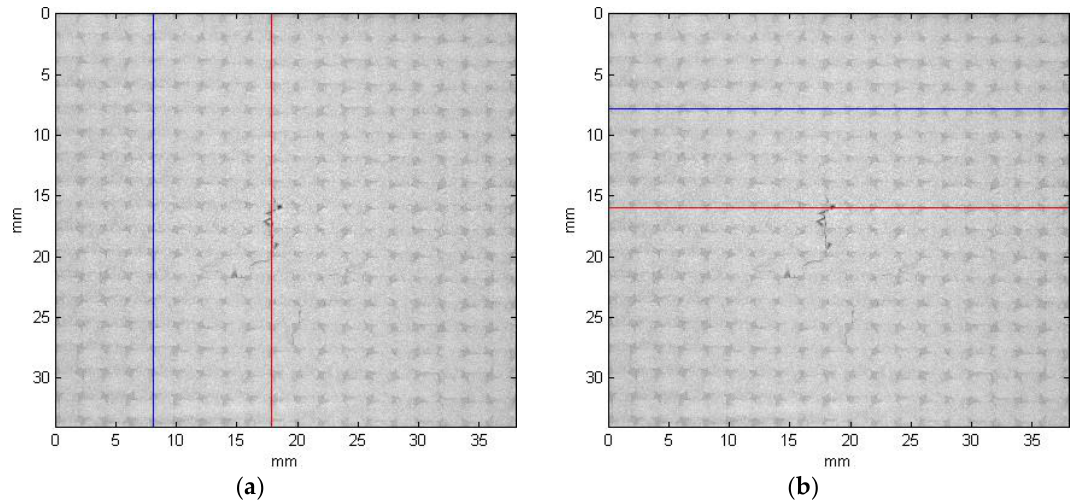
Figure 16. Positions of exemplary data vectors (not passing and passing through damage) in CT slices: ( a ) columns no. 368 and 814; ( b ) rows no. 357 and 726.